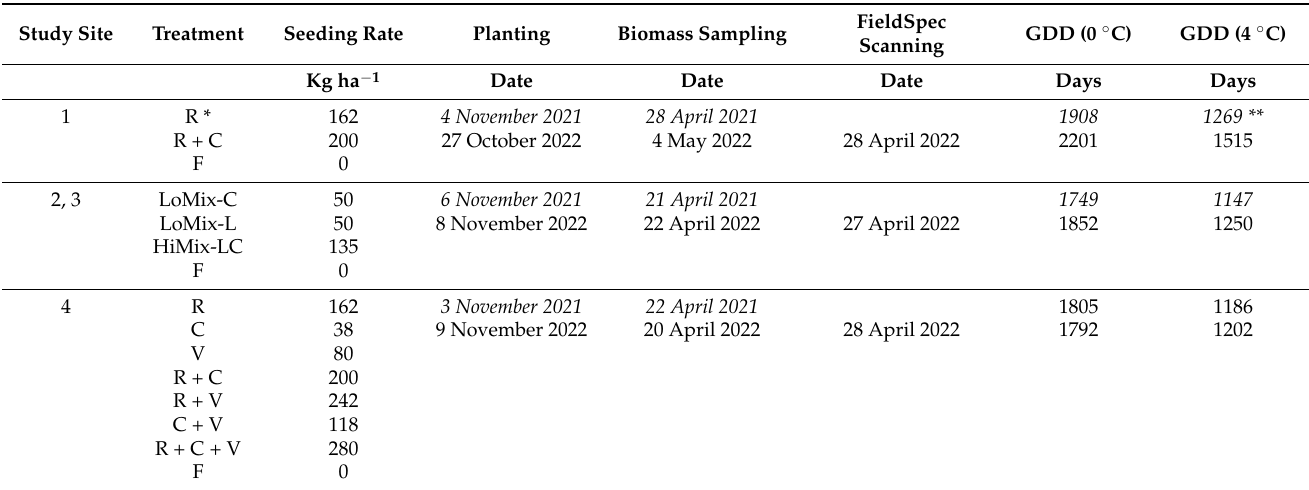
Table 1. Description of study sites and sampling